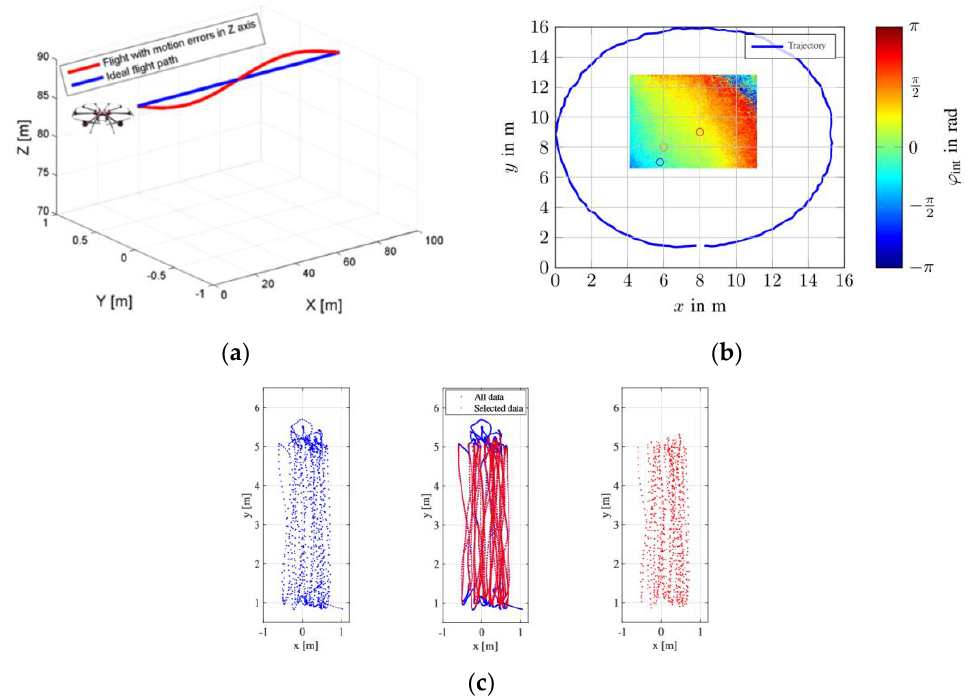
Figure 12. Examples of possible trajectory for USA-borne SAR: ( a ) Linear scan (after [54]), ( b ) circular trajectory (after [47]), and ( c ) multi-scan (after [51]).